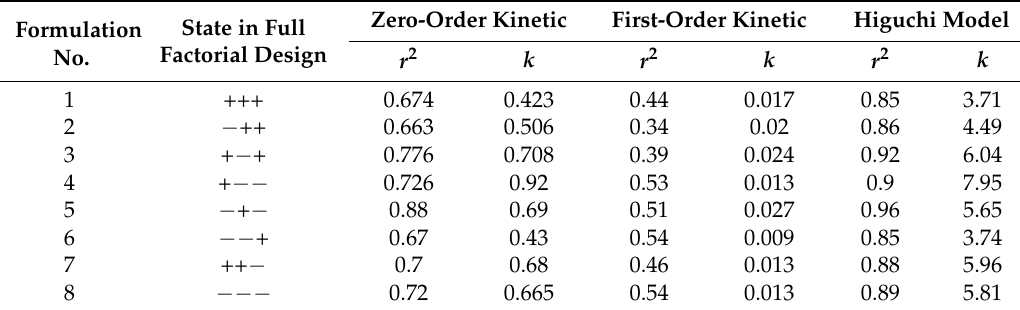
Table 4. A comparison between correlation coefficient ( r 2 ) and release rate constant ( k ) from nanostructure lipid carriers (NLCs) in different pharmacokinetic models. Formulation